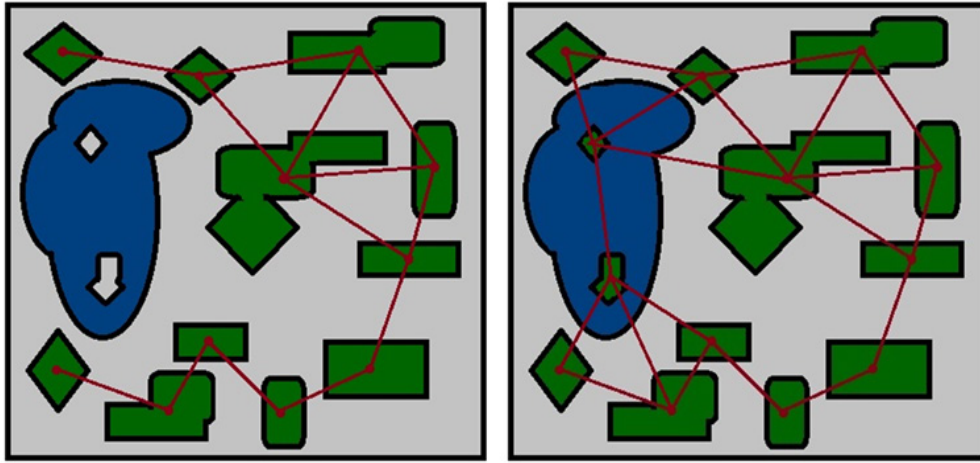
1. Connectivity of the landscape when (A) overlooking islands and (B) considering islands as suitable habitat. Areas in blue indicate water, areas in green indicate suitable habitat, and red lines indicate movement